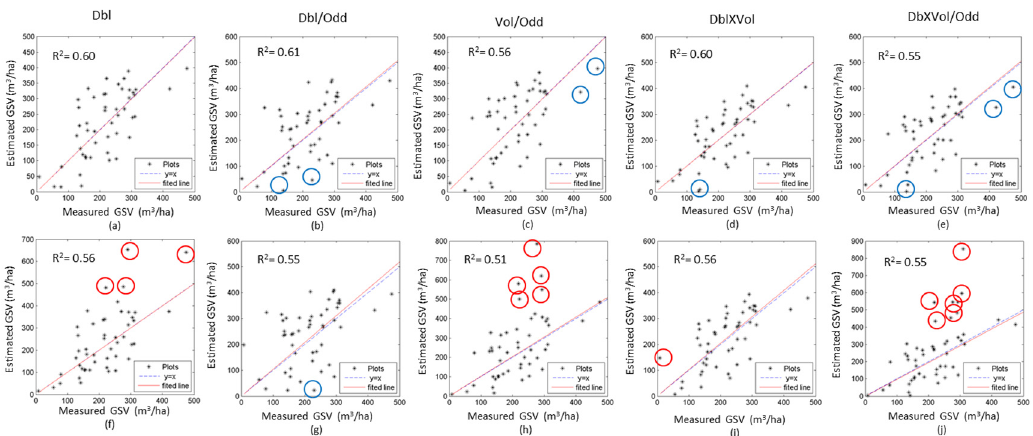
Figure 7. The scatter diagrams between the observed and estimated GSV using the SAR image acquired on 30 June 2016. The results of the GLM (a–e) and the semi-exponential model (f–j) are shown with difference variables. Red circle and blue circle denote the overestimated, and underestimated GSV, respectively.